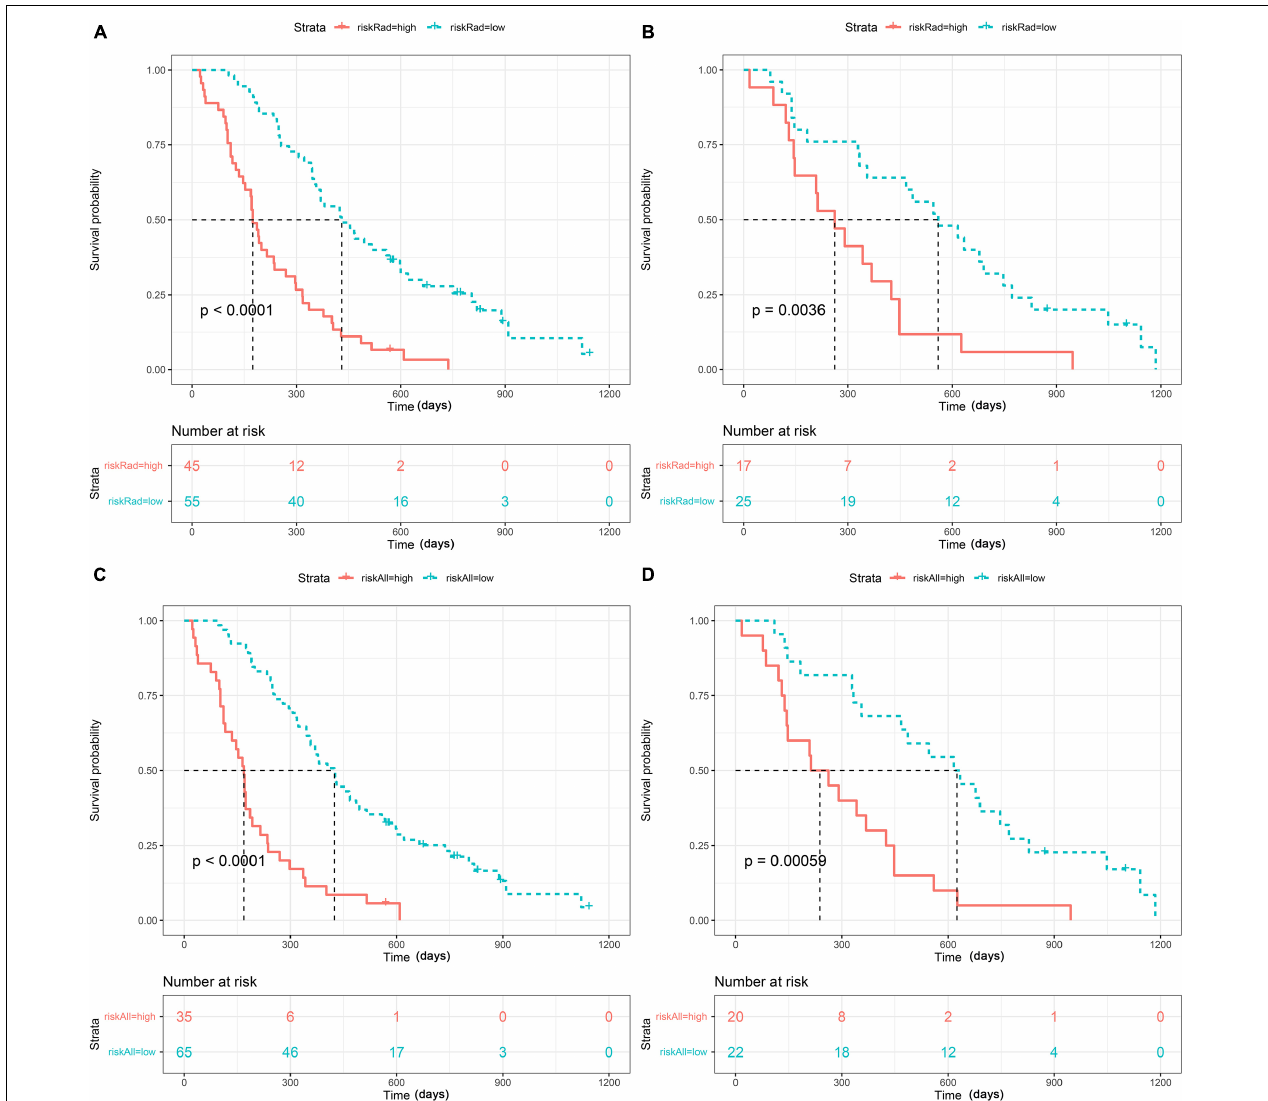
FIGURE 4 | Strata: index for risk stratification. Kaplan–Meier analysis of the overall survival (OS) of patients based on the radiomics model with optimal cutoff values (1.2311) in the training set (A) and the test set (B) and based on the Radiomics + Clinical model with optimal cutoff values (1.1489) in the training set (C) and the test set (D) .